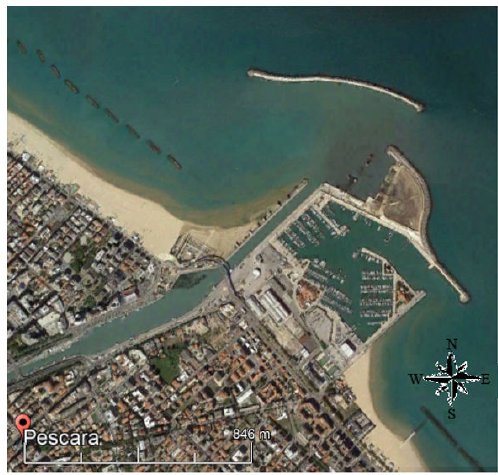
Figure 2. Satellite view of the Pescara Harbour coastal area.